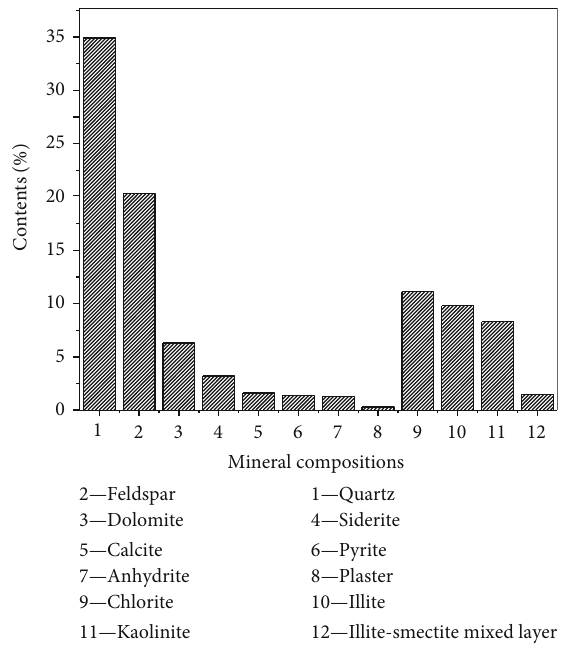
Figure 1: Mineral compositions of Karamay oil